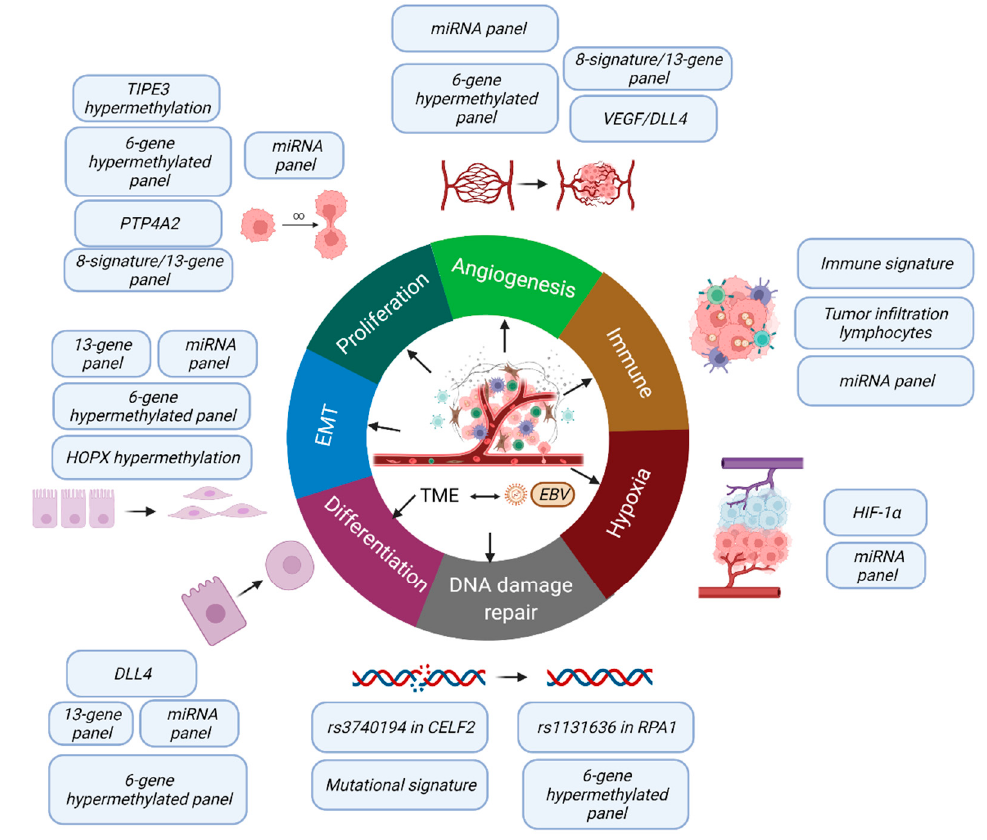
Figure 2. A summary of the biological functions involved in the biomarkers identified in this review. We identified the molecular changes for patients’ genetics (germline single-nucleotide polymorphisms (SNPs) and mutational signatures), epigenetics (DNA methylation and microRNA), and gene expression from cancer cells and immune cells in the tumor microenvironment (TME) in determining the clinical outcome for NPC. These molecular changes trigger various biological pathways to influence cancer proliferation, DNA damage repair, angiogenesis, hypoxia, epithelial-to-mesenchymal transition (EMT), differentiation, and immune response. Created with https://biorender.com/ [33] (accessed on 15 March 2022).